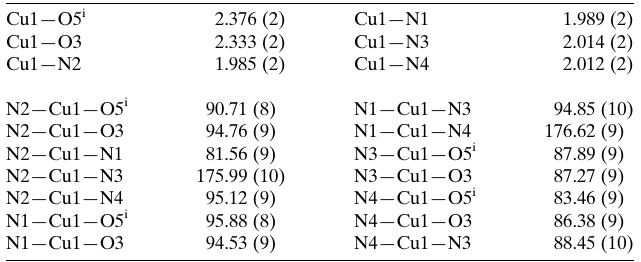
Table 2 Hydrogen-bond geometry (A˚ , (cid:4) ).